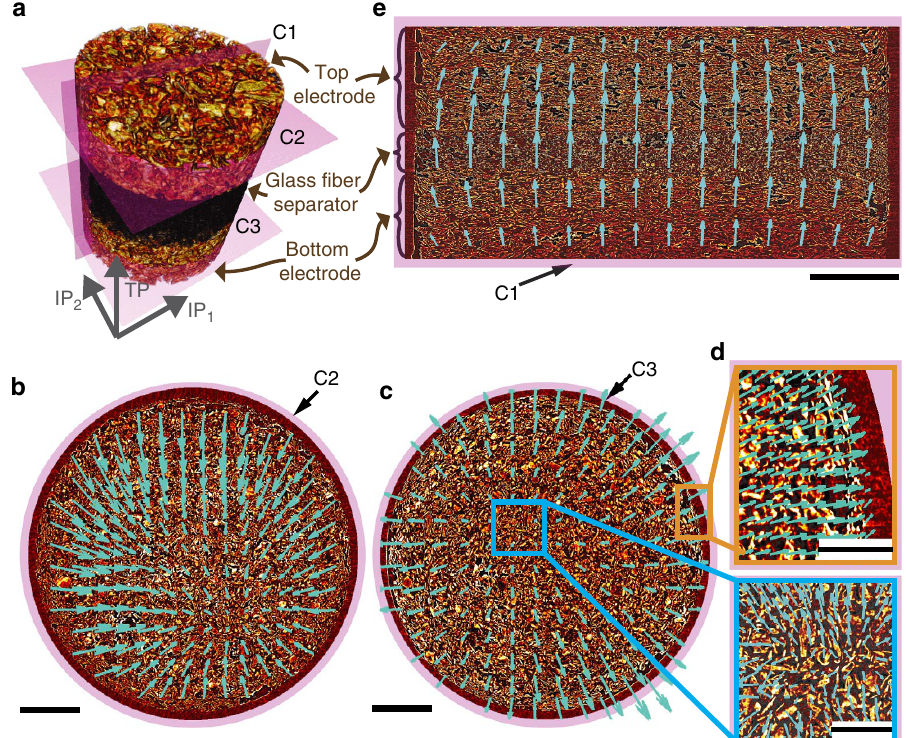
Figure 2 | Digital volume correlation. ( a ) Schematic of the two electrodes, the separator (black) and the cuts C1, C2, and C3 (purple). The coordinate system indicates the two IP directions and the TP direction. ( b ) Top electrode with superimposed vector field indicating the IP electrode contraction from the first to the last time step (vectors are scaled by a factor 60). Scale bar length, 300 m m. ( c ) Analogue graphic for the bottom electrode. Vectors point outwards, indicating an expansion. Scale bar length, 300 m m. ( d ) Zoom-ins showing the full vector field resolution within the boundary regime (orange box, vectors rescaled by a factor 8) and within a central part in the electrode (blue box, vectors rescaled by a factor 80). Scale bar length, 100 m m. ( e ) Vertical cut through both electrodes and the separator with superimposed vector field (vectors scaled by a factor 8). Scale bar length, 300 m